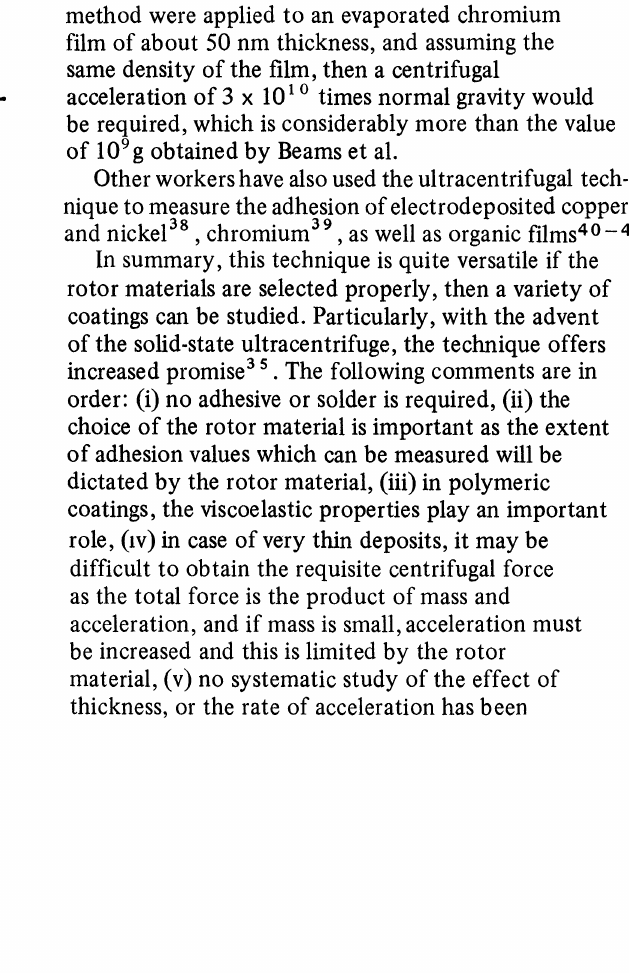
Bursting-speeds of spherical steel rotors (from reference 34a) Rotor Peripheral Rotor speed speed Centrifugal